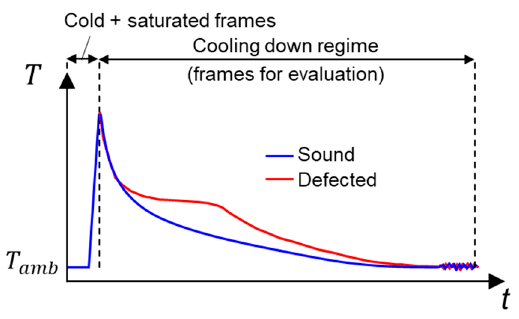
Figure 2. Graphical representation of the thermal response for a sound and defected pixel.